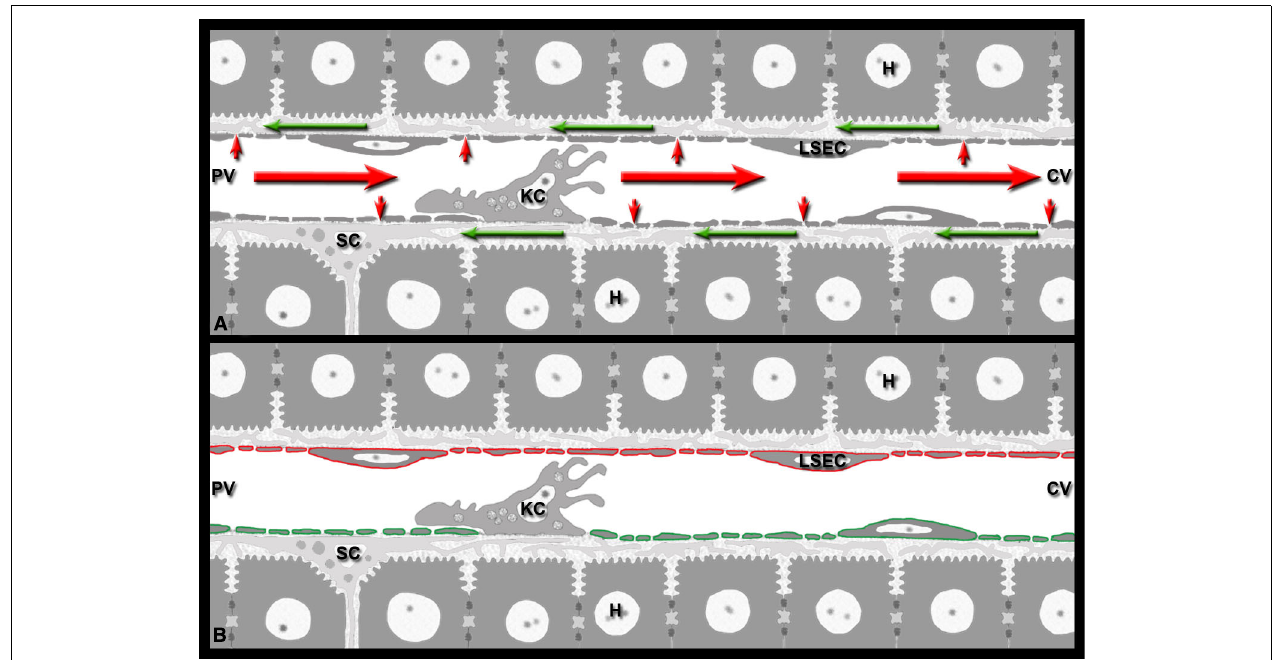
FIGURE 1 | Immunological implications of the hepatic blood-lymph countercurrent. (A) The liver generates lymph by filtering blood plasma (small red arrows) through the sieve plates of the sinusoidal endothelial cells (LSEC) into the perisinusoidal space of Disse formed by LSECs and hepatocytes. The lymph (green arrows) flows inside the space of Disse around the perisinusoidal